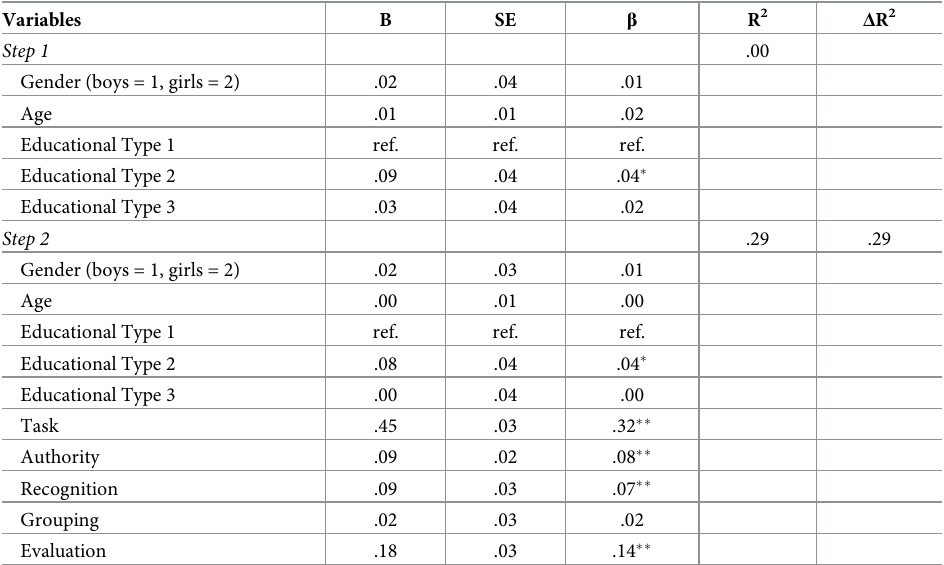
Table 2. Summary of hierarchical regression analysis for variables predicting autonomous